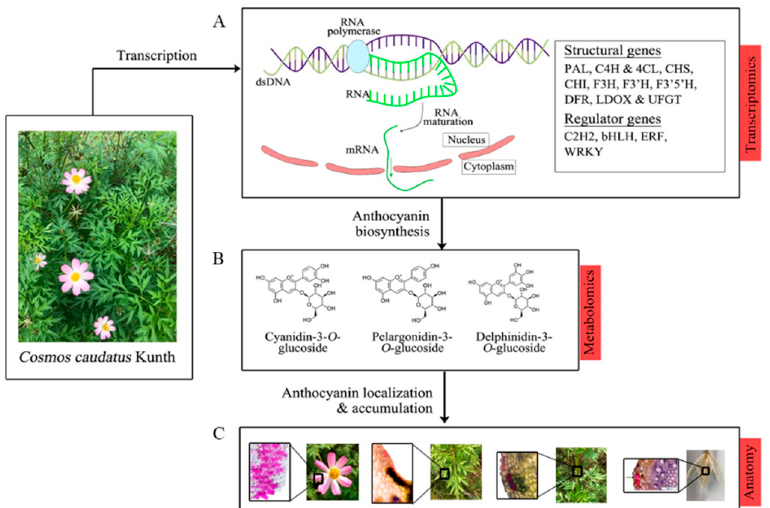
Figure 9. Schematic diagram showing the anthocyanin biosynthesis occurrence in four different tissues (leaf, flower, stem, and root) of C. caudatus Kunth. using three independent platforms: transcriptomics, metabolomics, and anatomy. ( A ) The 11 main structural genes responsible for the anthocyanin biosynthetic pathway and its regulatory genes were annotated from transcriptome data of the RNA of four different tissues of C. caudatus Kunth., assembled as a single set of metadata for gene identification. ( B ) LC-MS detected three major anthocyanin peaks in four tissues of the species studied (3 biological replicates each) based on m / z values obtained from the chromatogram. ( C ) Transverse sectioning of the different tissues studied showed anthocyanin localized cell parts through the naturally occurring coloration observed under the light micro ‐ scope.